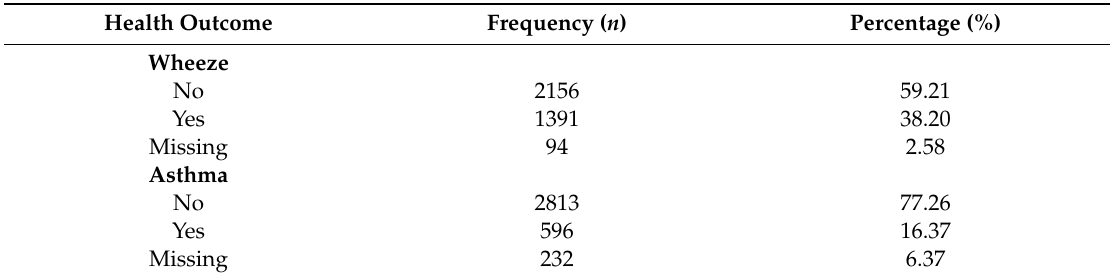
Table 2. Prevalence of wheeze and asthma among the study participants ( n = 3641).